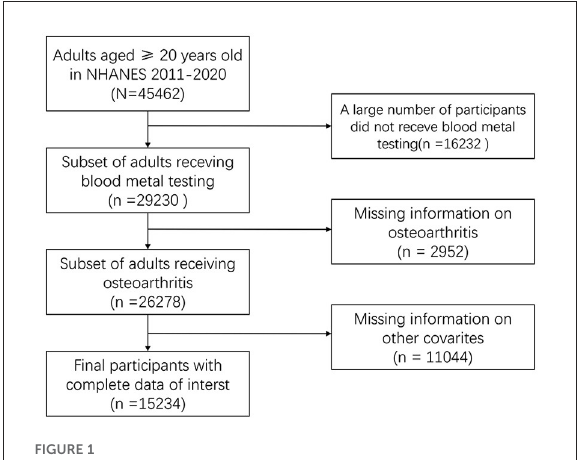
FIGURE1 Flowchart of dataset